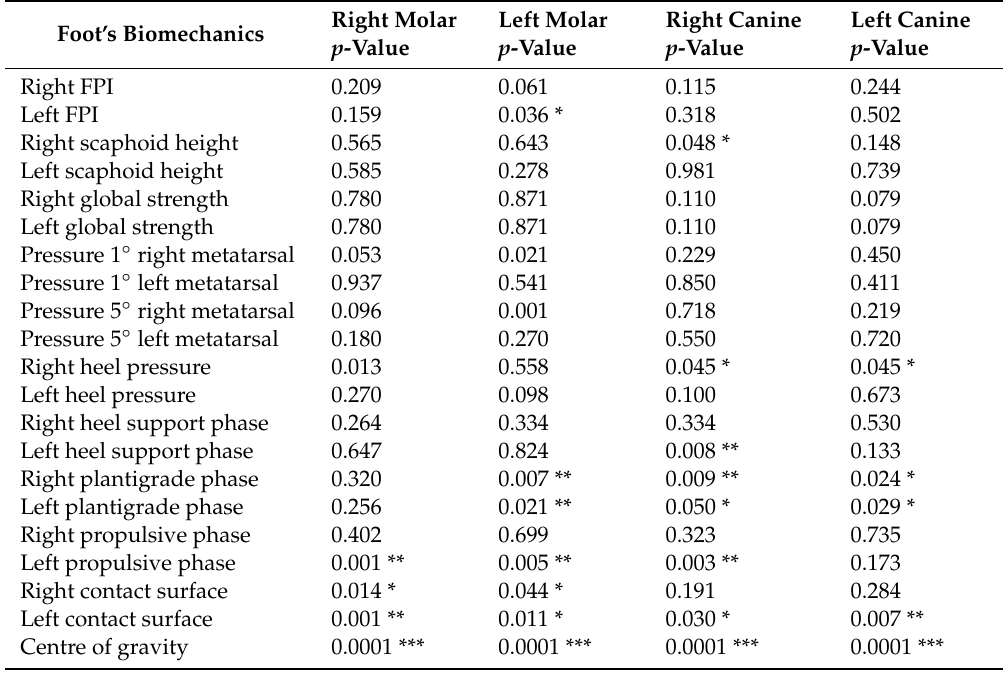
Right contact surface